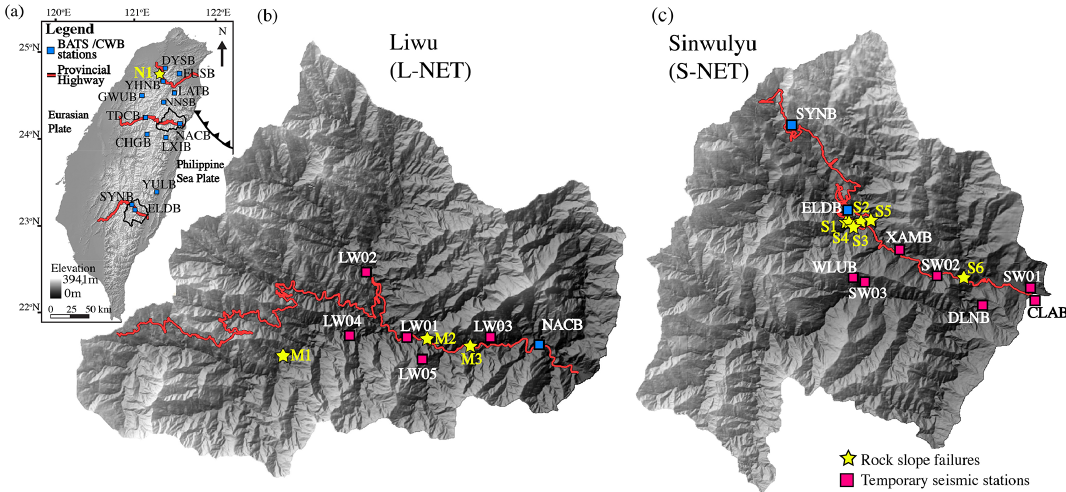
Figure 1. The research area and distribution of seismic stations and 10 rock slope failures (RSFs, yellow stars): (a) topographic map of Taiwan showing the three provincial highways (red lines) and BATS/CWB stations (blue squares); (b) Liwu catchment, the east flank of the central provincial highway, and the temporary seismic network (L-NET, pink squares); (c) Sinwulyu catchment, the east flank of the southern provincial highway, and the temporary seismic network (S-NET, pink squares). The data of the digital terrain model (DTM) of Taiwan and two catchments are from the Government Open Data Platform,